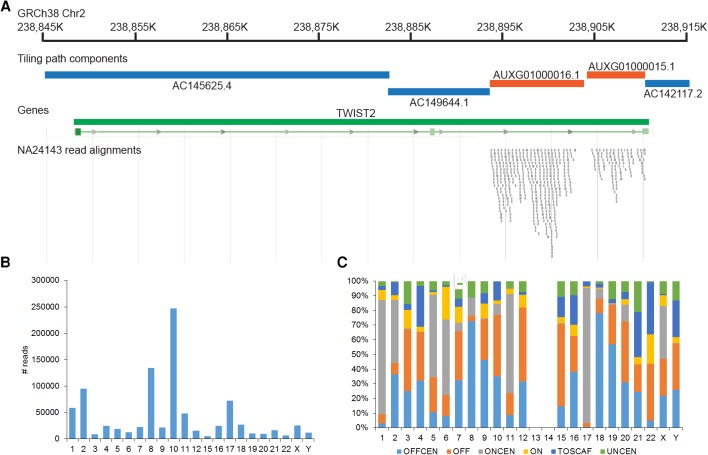
NA24143 read alignments to GRCh38. (A) Schematic showing the alignment of a subset of reads unmapped on GRCh37 to GRCh38. Reads align to GRCh38 at the position of components that were added to span a GRCh37 assembly gap (orange). (B) Graph showing counts of reads uniquely mapped to unchanged regions of GRCh37 that uniquely map to nonequivalent locations in GRCh38. (C) Chart describing the GRCh38 distribution of reads from B, categorized by sequence location (same or different chromosome/scaffold) and sequence type (centromeric versus noncentromeric): (OFFCEN) movement to centromeric sequence on a different chromosome; (OFF) movement to noncentromeric sequence on a different chromosome; (ONCEN) movement to centromeric sequence on the same chromosome; (ON) movement to noncentromeric sequence on the same chromosome; (TOSCAF) movement to a noncentromeric unlocalized or unplaced scaffold; (UNCEN) movement to an unplaced scaffold containing centromere-associated sequence.